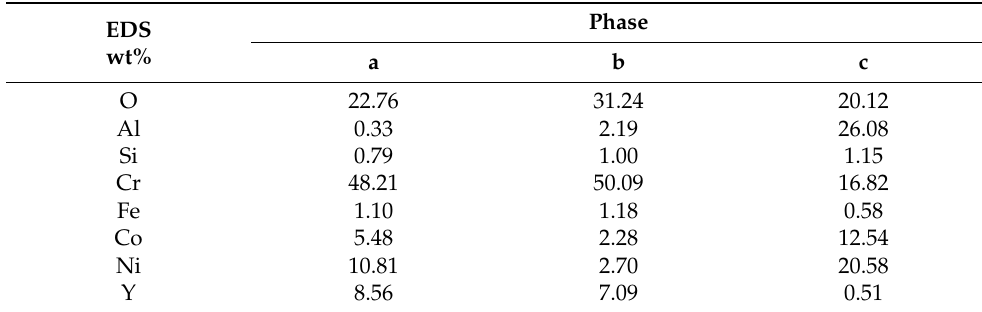
Figure 13. BSE–SEM image of pre-oxidized HVOF–NiCoCrAlYTa (air, 900 ◦ C, 24 h, 0.5 ◦ C/min) and exposed to NaCl–KCl at 700 ◦ C, showing penetration at the outer surface of the top coating, adapted from [112]. Table 2. Element percentage from EDS analysis of HVOF–NiCoCrAlYTa pre-oxidized surface after exposure to NaCl–KCl salt (see Figure 13), data from